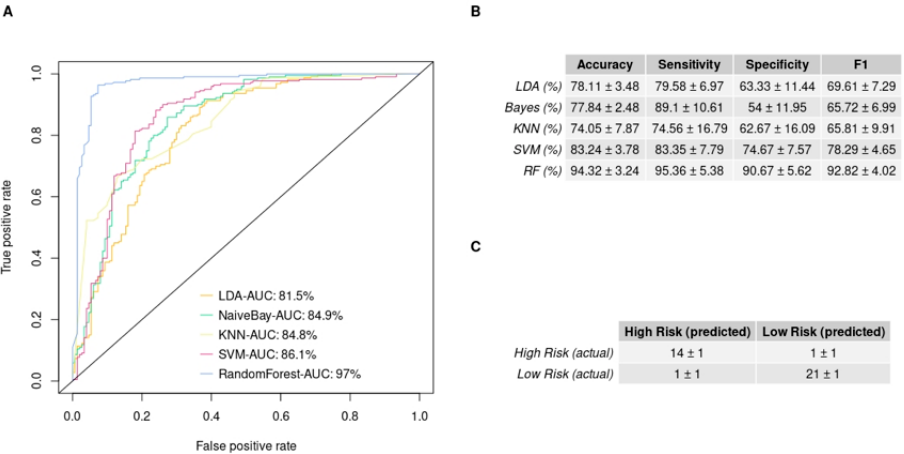
Figure 3. Supervised machine learning algorithms’ performance in discriminating the low- and high-risk group employing miRNA expression values, measured by qRT-PCR: ( A ) The ROC curves of each model predicting the risk group of the validation set. It illustrates the predictive ability that each model has over true positives and false positives. The area under curve (AUC) is also reported; ( B ) The table provides the models and the metrics used for their evaluation (sensitivity is the ability of the models to predict the high risk and specificity the ability to predict the low risk). The table summarizes the mean value and the standard deviation of each mode performance over 10 repetitions of the bootstrap method; ( C ) The mean confusion matrix of the model that scores the best performance on the validation set after 10 repetitions. In the upper left corner of the table, we can see the true positive predictions, and in the lower right, the true negative predictions are depicted.